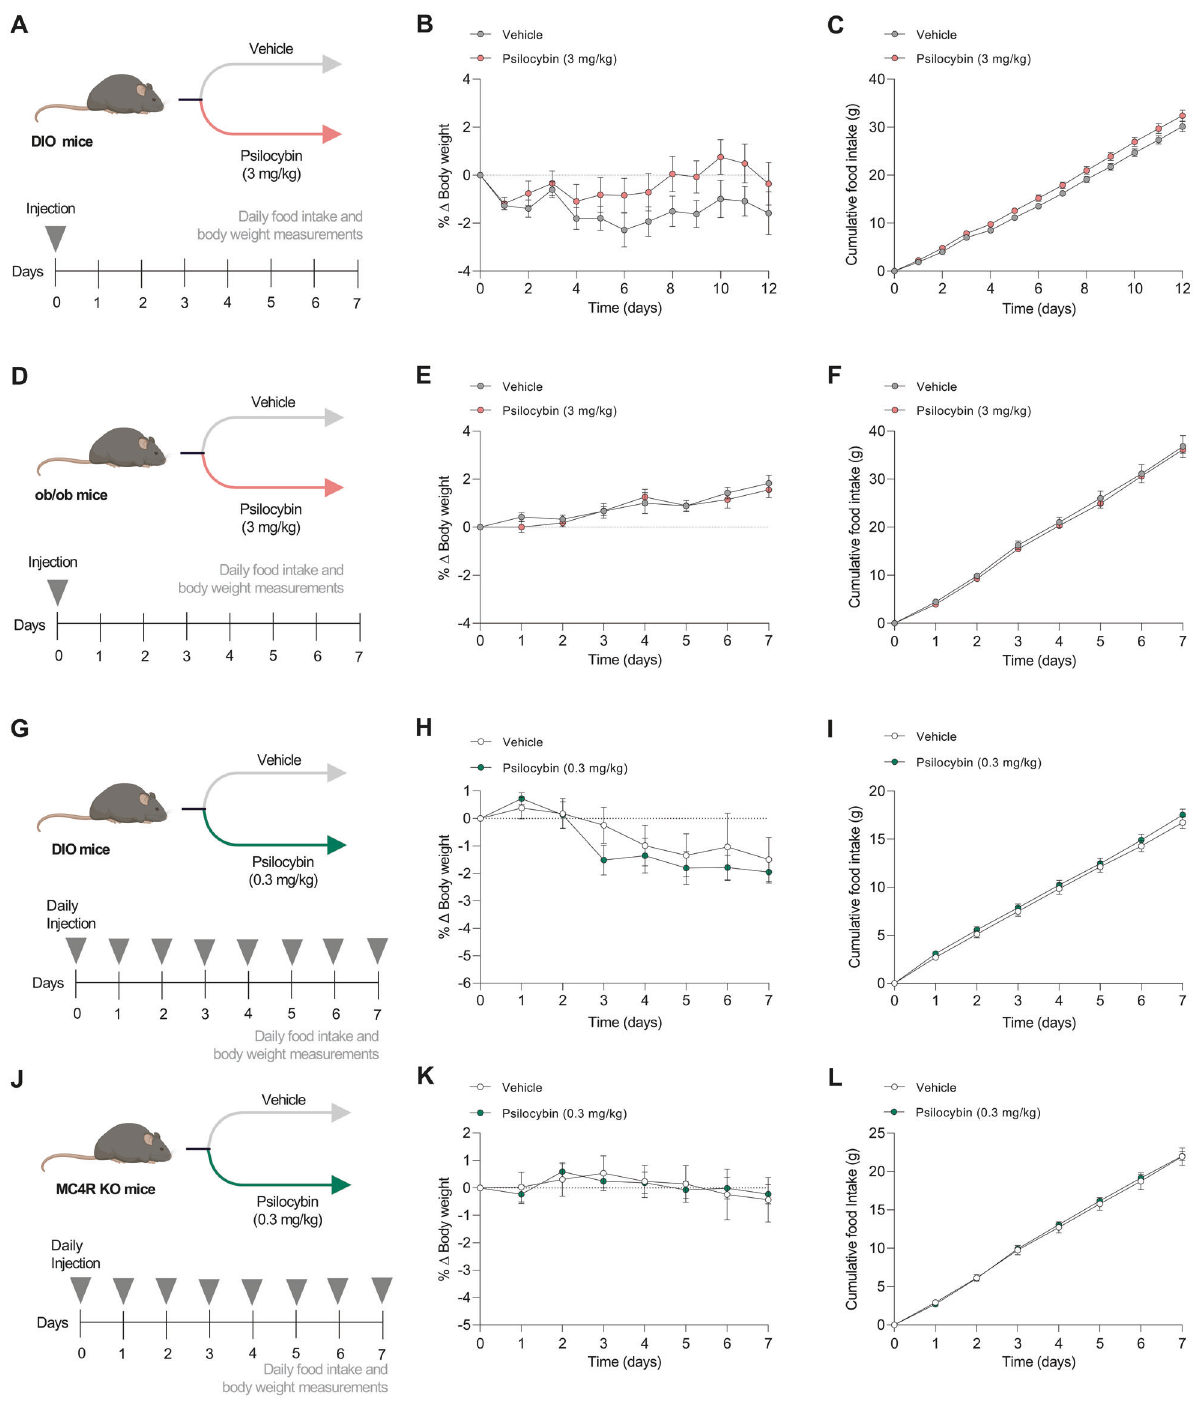
Fig. 2 A single high dose or microdosing psilocybin does not have an effect on body weight or food intake in mouse models of obesity. A Schematic for single injection study in diet-induced obese (DIO) mice ( n = 8 per group). B Body weight in the 12-day period following injection of psilocybin (3 mg/kg) or vehicle. C Cumulative food intake in the 12 days following injection of psilocybin or vehicle. D Schematic for single injection study in ob/ob mice ( n = 7 – 9 per group). E Body weight. F Cumulative food intake. G Schematic for microdosing study in DIO mice. Mice were injected daily with psilocybin (0.3 mg/kg; n = 7) or vehicle ( n = 6). H Body weight following daily injection of psilocybin (0.3 mg/kg) or vehicle for 7 days ( n = 6/7 per group). I Food intake. J Schematic for microdosing study in MC4R KO mice ( n = 8 per group). K Body weight. L Food intake. Data are presented as mean ± SEM (analyzed by RM two-way ANOVA with Bonferroni ’ s attenuates weight gain on a moderate-fat diet [49]. In contrast, we demonstrate that a single dose of 3 mg/kg psilocybin does not in fl uence the body weight or food intake of ob/ob mice on a high- fat diet (Fig. 2E, F).